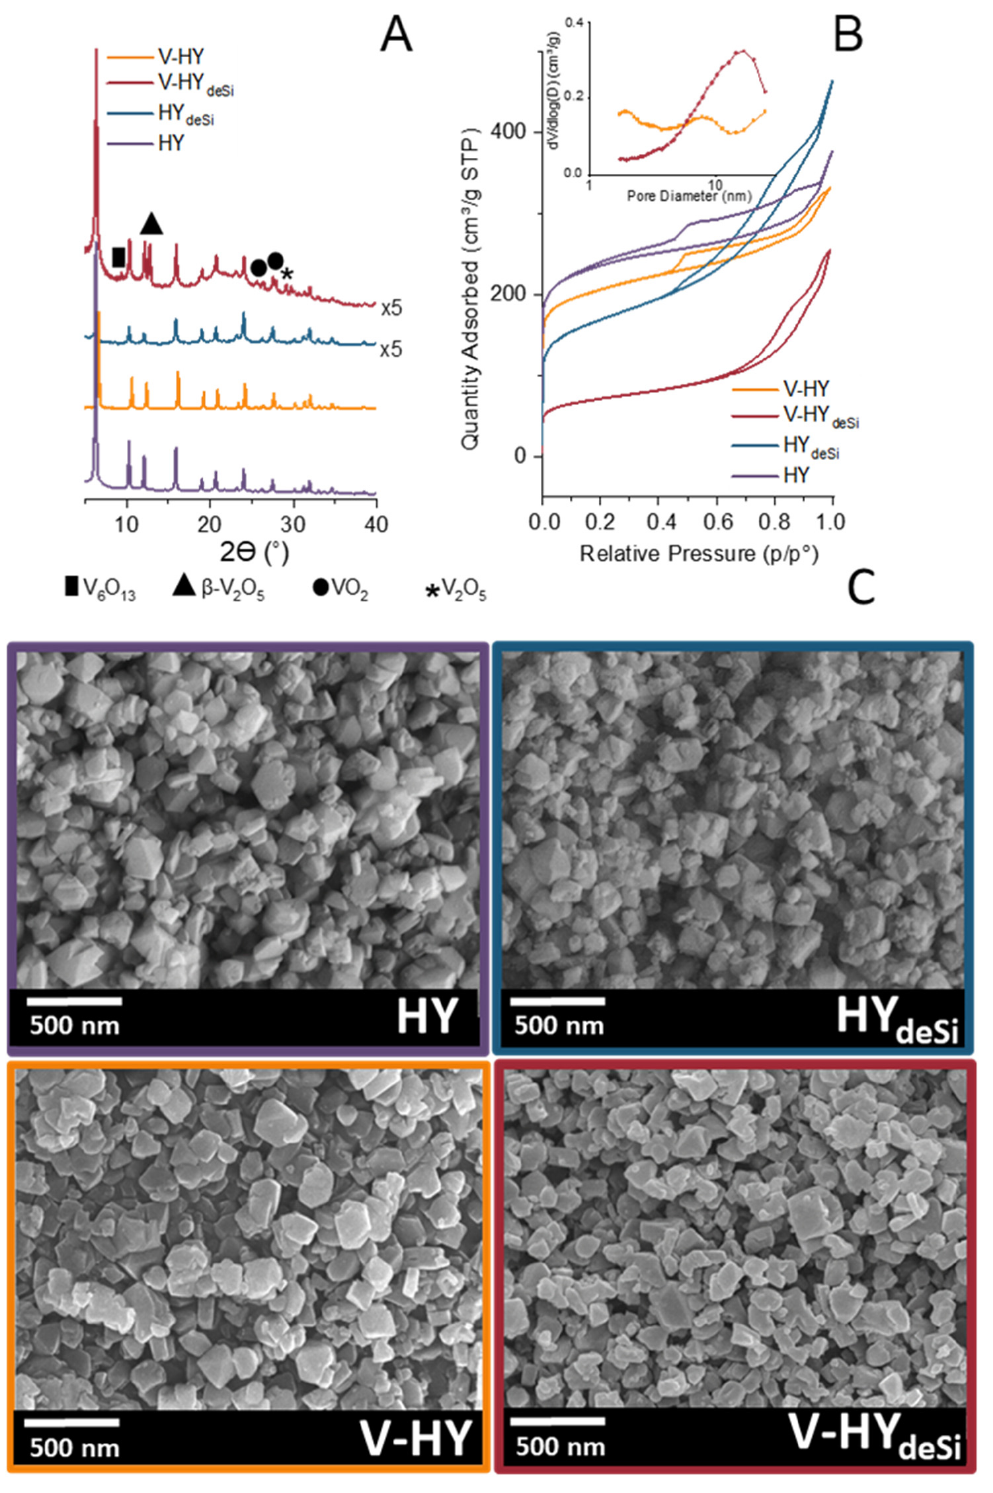
Figure 1. The XRD patterns ( A ), N 2 physisorption isotherms with pore size distribution (inset) ( B ), and SEM pictures of V- and H-zeolites ( C ).